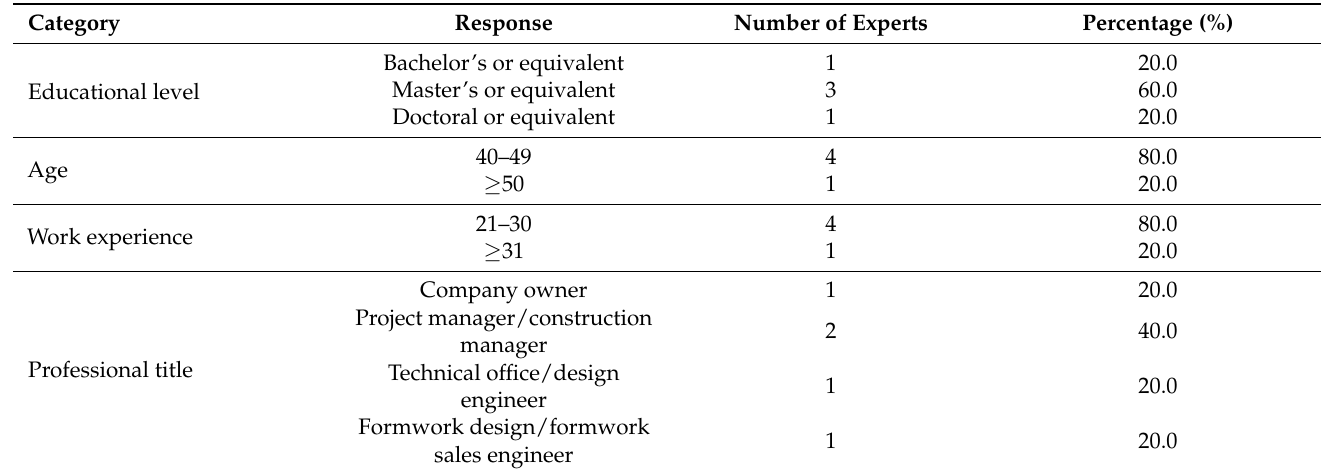
Table 2. Demographic information of the experts in the decision-making